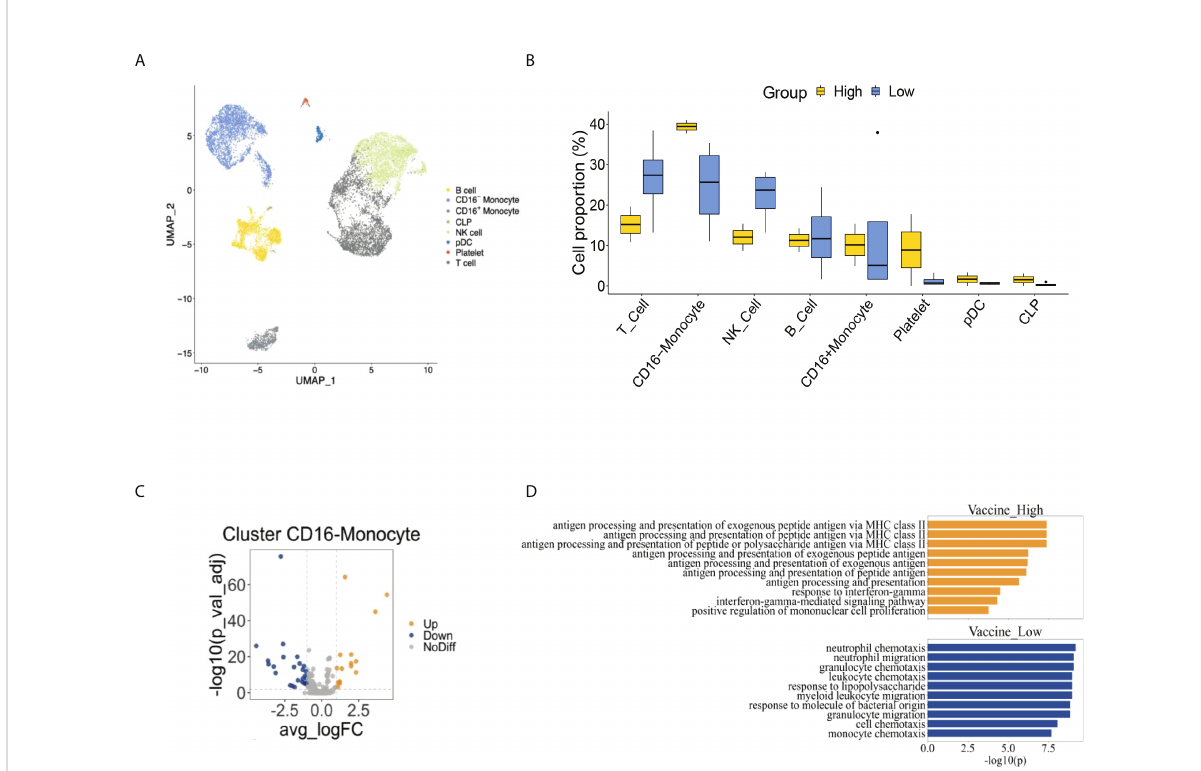
FIGURE 2 The comprehensive cell atlas of peripheral blood mononuclear cells of rheumatoid arthritis patients with high and low anti-SARS-CoV2-IgG antibodies. (A) UMAP visualization of peripheral blood mononuclear cells from rheumatoid arthritis patients. (B) The proportion of cell types between high and low anti-SARS-CoV2-IgG antibody groups. (C) Volcano plot of CD16-monocyte showed differential expressed genes of high anti-SARS-CoV2-IgG antibody group comparing to low anti-SARS-CoV2-IgG antibody group. (D) Pathway analysis between high and low anti- SARS-CoV2-IgG antibody